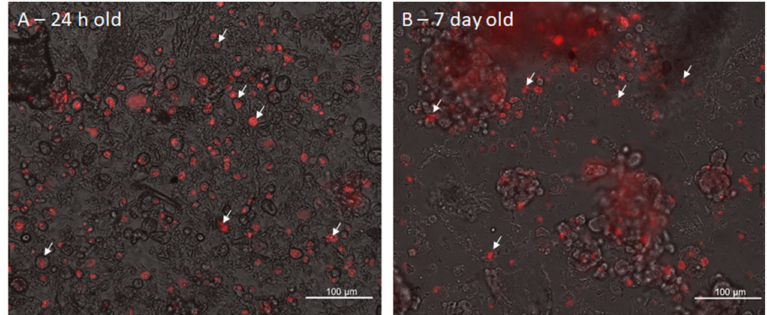
Figure 13. Fluorescence image (Propidium Iodide) of electroporated 3D cultures at 24 h ( A ) and 7 days ( B ). White arrows indicate electroporated cells.